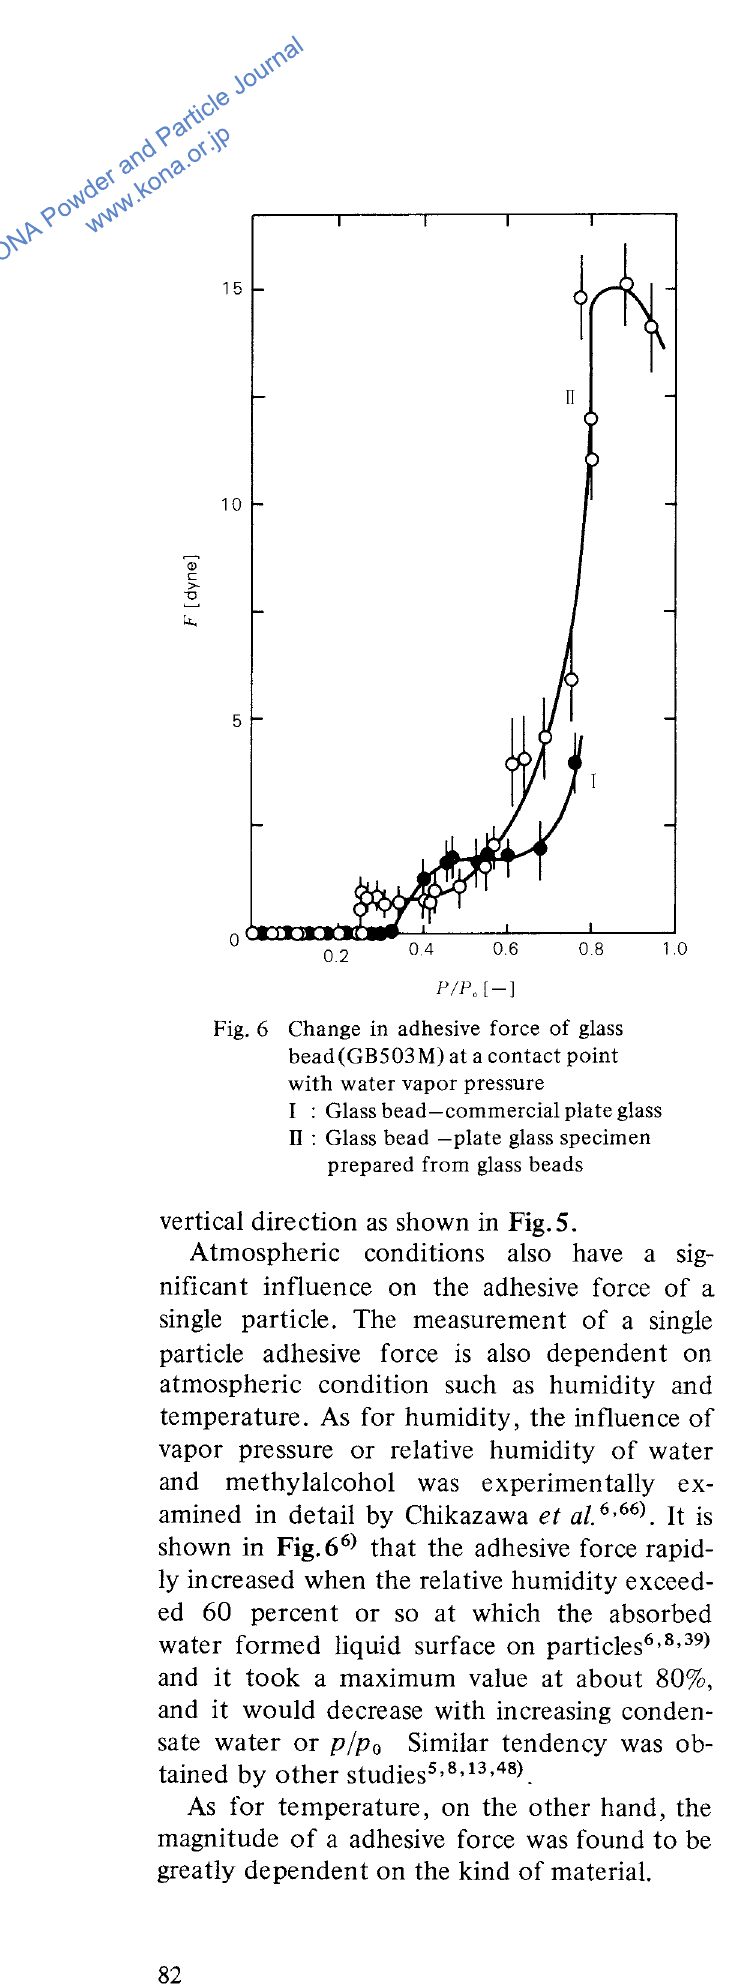
Fig. 7 Statistical representation of particle arrange ment in powder